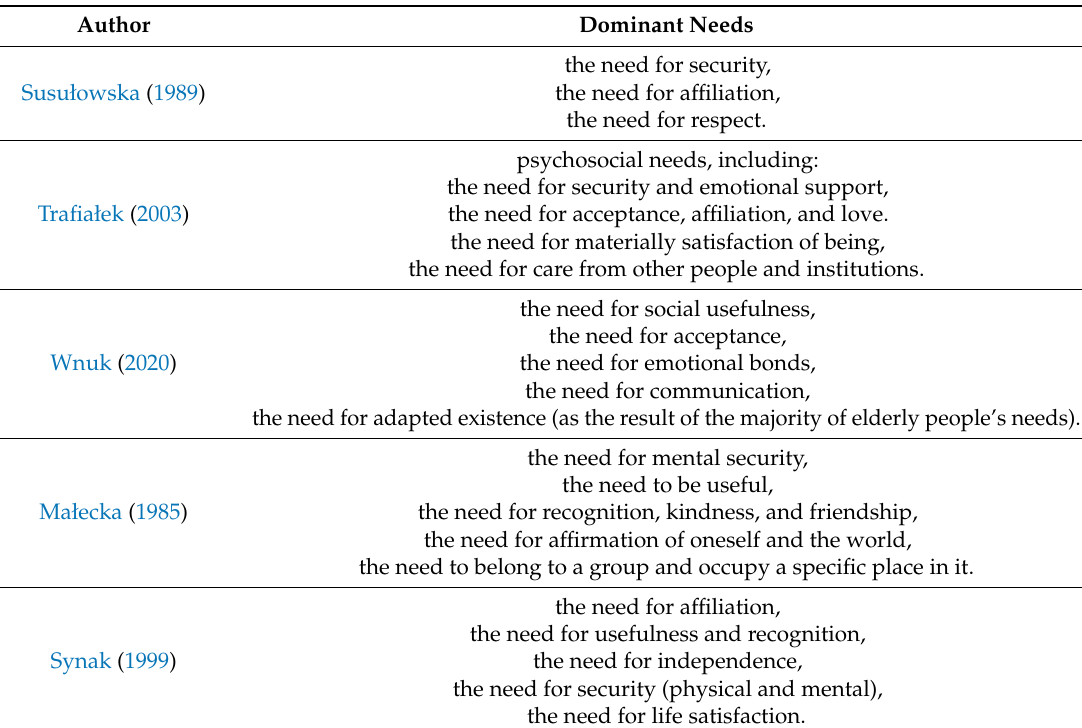
Table 1. Dominant needs in old